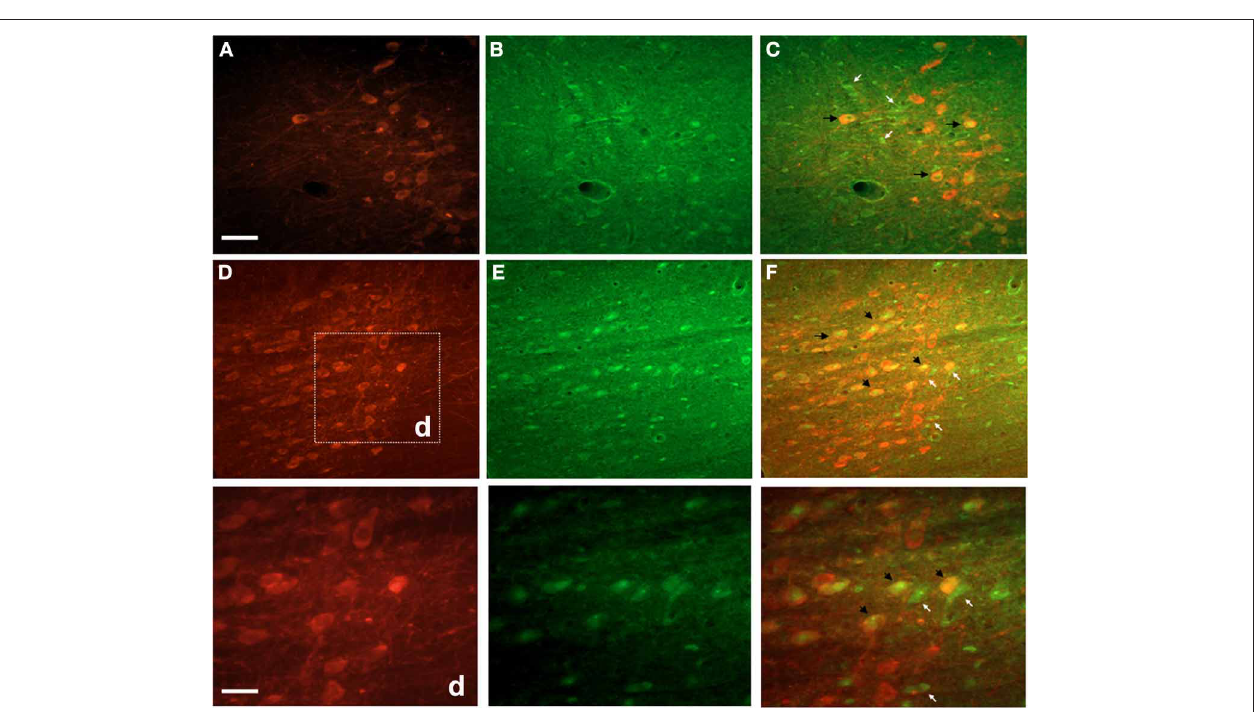
FIGURE 3 | Fluoro-Jade C staining in brain parasagittal sections of F1- (panel A) or F2- (panel B) generation groups at the level of Substantia nigra (SN) or Corpus Striatum (CS). No labeling was detected in cell bodies or processesof SN (Aa, Ab) andCS (Ac, Ad) in adult animals of F1 generation. However,FJC positive cell bodies and processeswere detectedin the SN pars